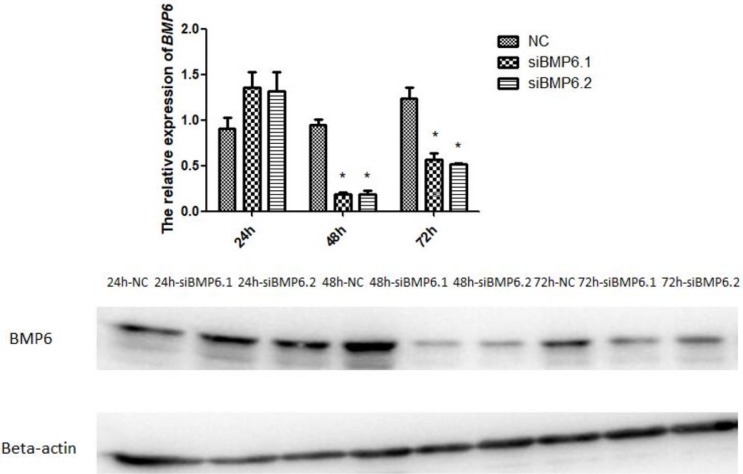
The interference efficiency of the two siRNAs were marked and stable.(A) The expression levels of BMP mRNA by qRT-PCR. All values represent means ± SEM (n = 3). (*) represents statistical significance (P < 0.05). (B) The expression levels of BMP6 protein by western blot. The protein beta-actin was used as reference gene.